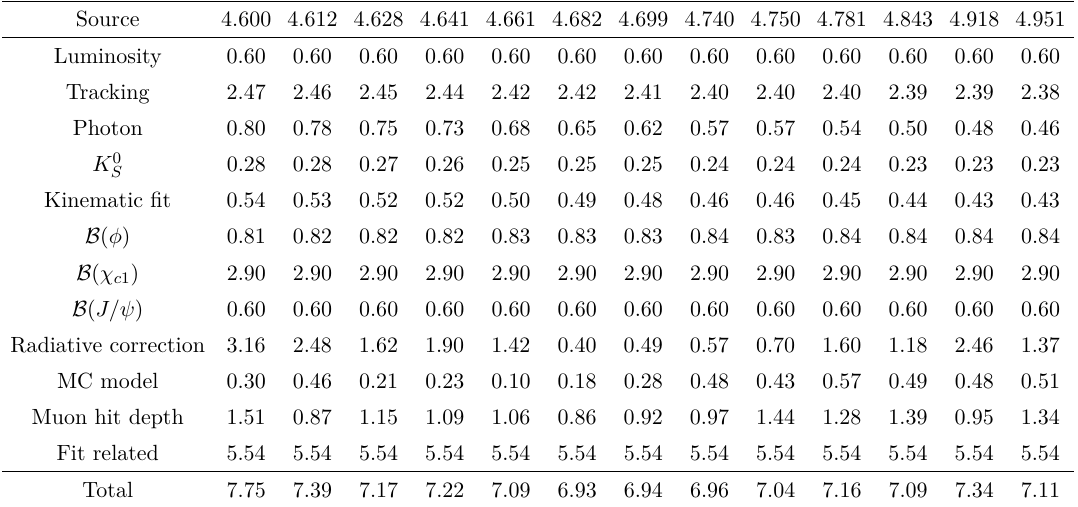
Table 13 . The systematic uncertainties (in %) for e + e − → φχ c 1 cross sections at each energy point.